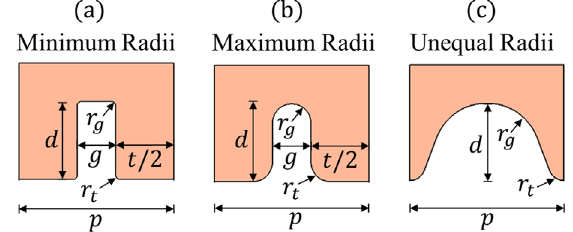
3. Dimensions for corrugation types: (a) minimum radii corners, (b) maximum radii corners, (c) rounded with unequal radii corners connected by tangent sidewalls, where t ¼ 2 r and g ¼ 2 r g